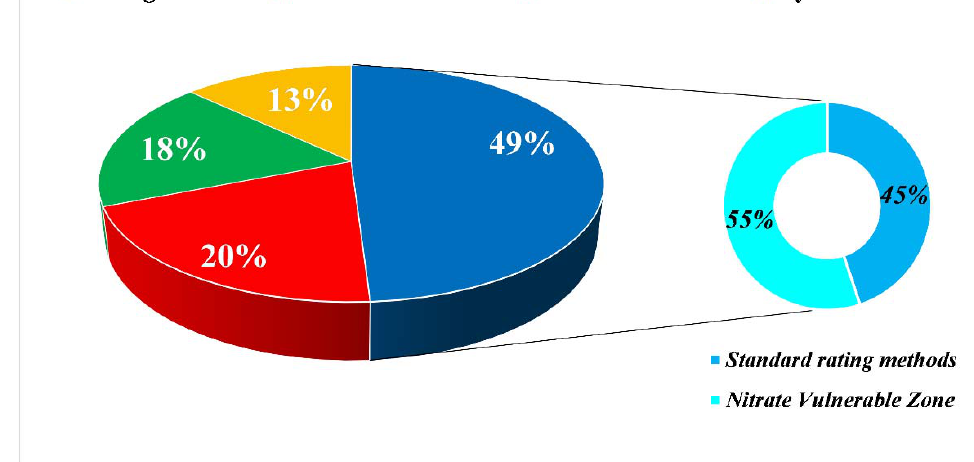
Figure 4. General statistics for the discusses categories.